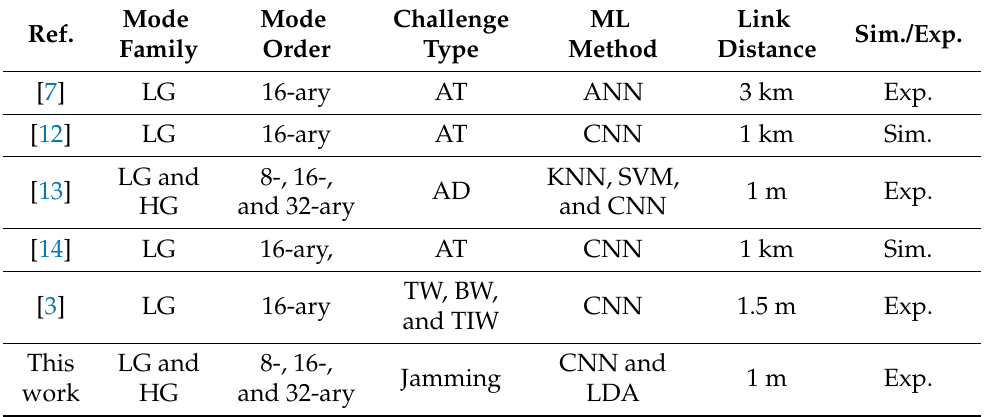
Table 1. ML-based identification of M-ary light pattern coding systems under different transmis- sion challenges.